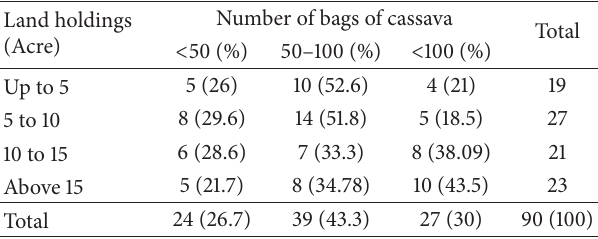
Table 2: Relationship between size of farms and yield of cassava. Land holdings